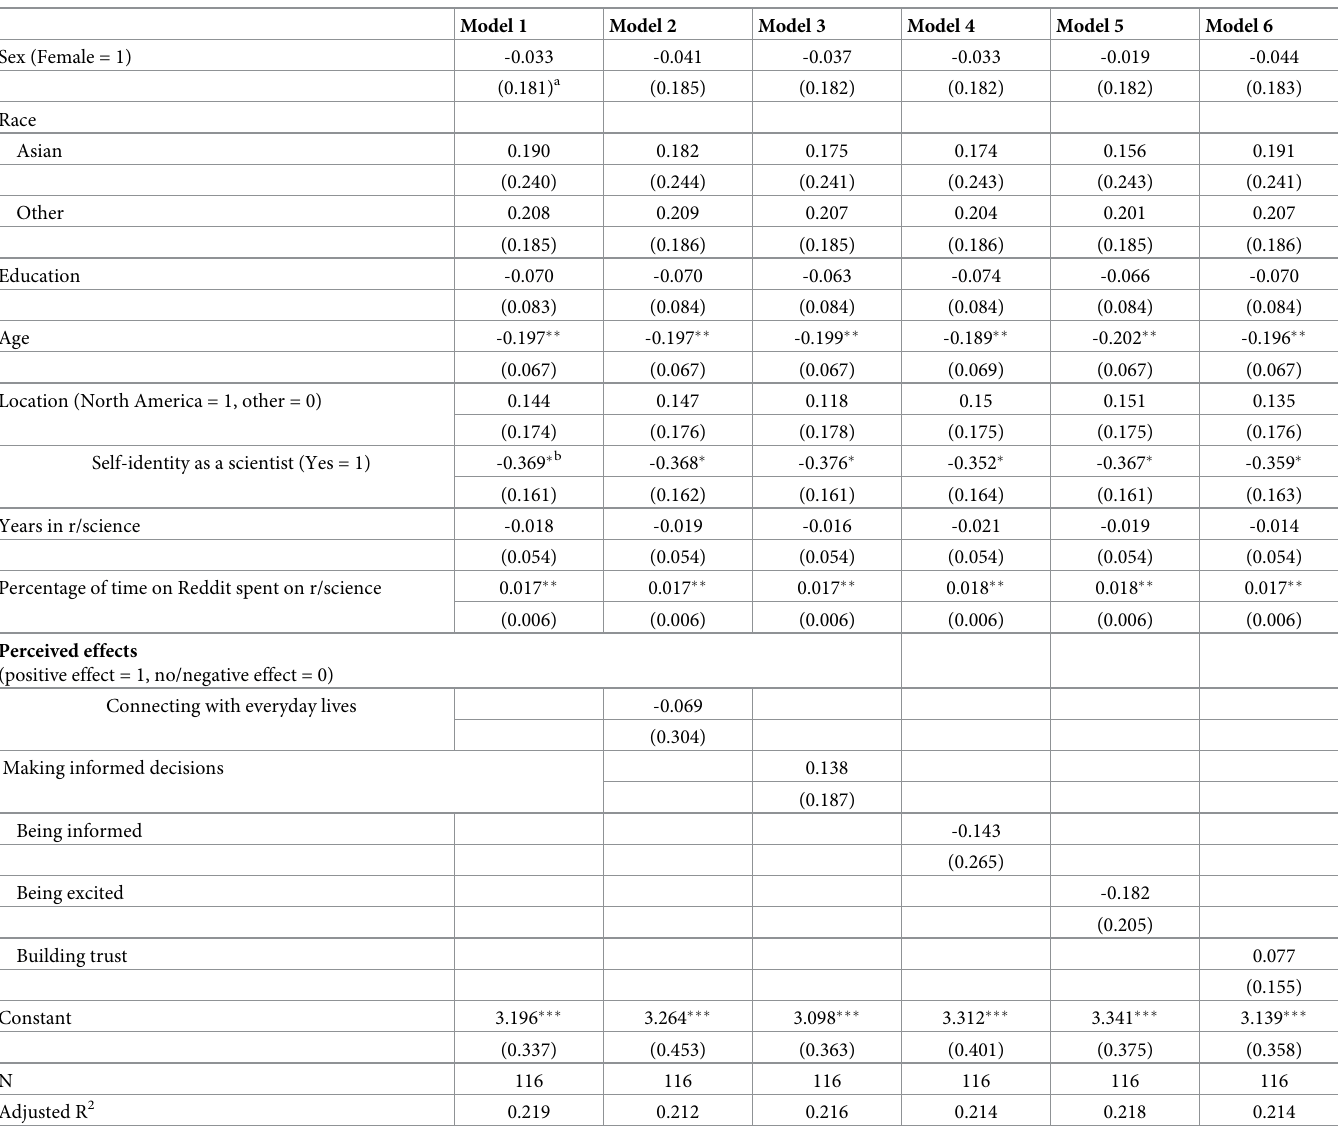
Table 2. Results of linear regression of users’ demographics and perceived effects on focused attention